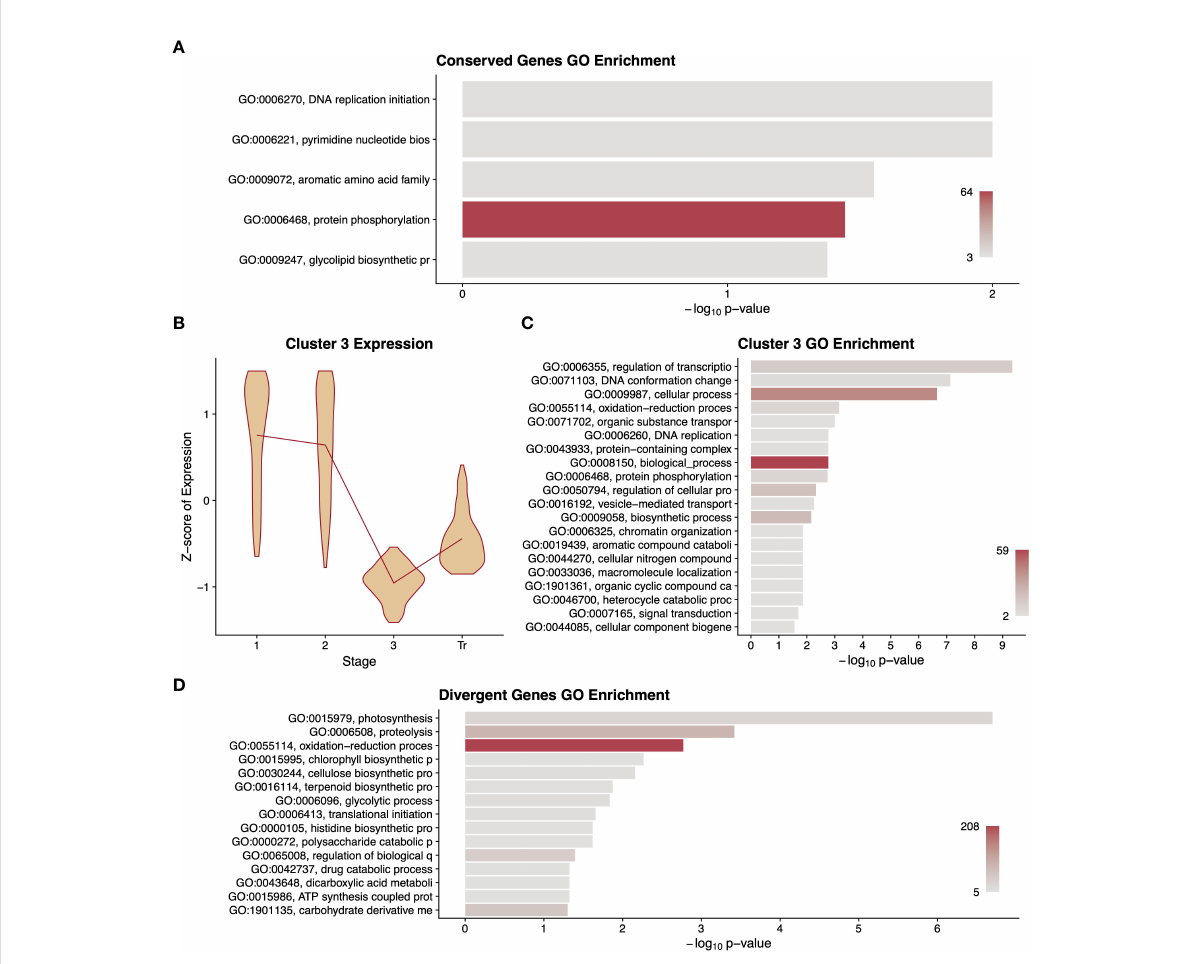
FIGURE 4 Summary of differentially expressed orthologous genes. A gene ontology (GO) term enrichment analysis (A) performed on differentially expressed genes that had conserved patterns among the three species. A representative cluster of 796 differentially expressed genes conserved among species is described with violin plots of normalised expression at each stage of development (B) along with a GO enrichment analysis (C) of the genes in that cluster. A gene ontology (GO) term enrichment analysis (D) performed on differentially expressed genes that had different patterns between fruit types. GO term descriptions to the left of the enrichment graphs are truncated for space and sorted by p-value. The bars are colored by the number of genes assigned to each GO term with legends in the lower right of the graph. Stages of fruit development in the axis of B-GD are numbered sequentially followed by “ Tr ” for transition to mature